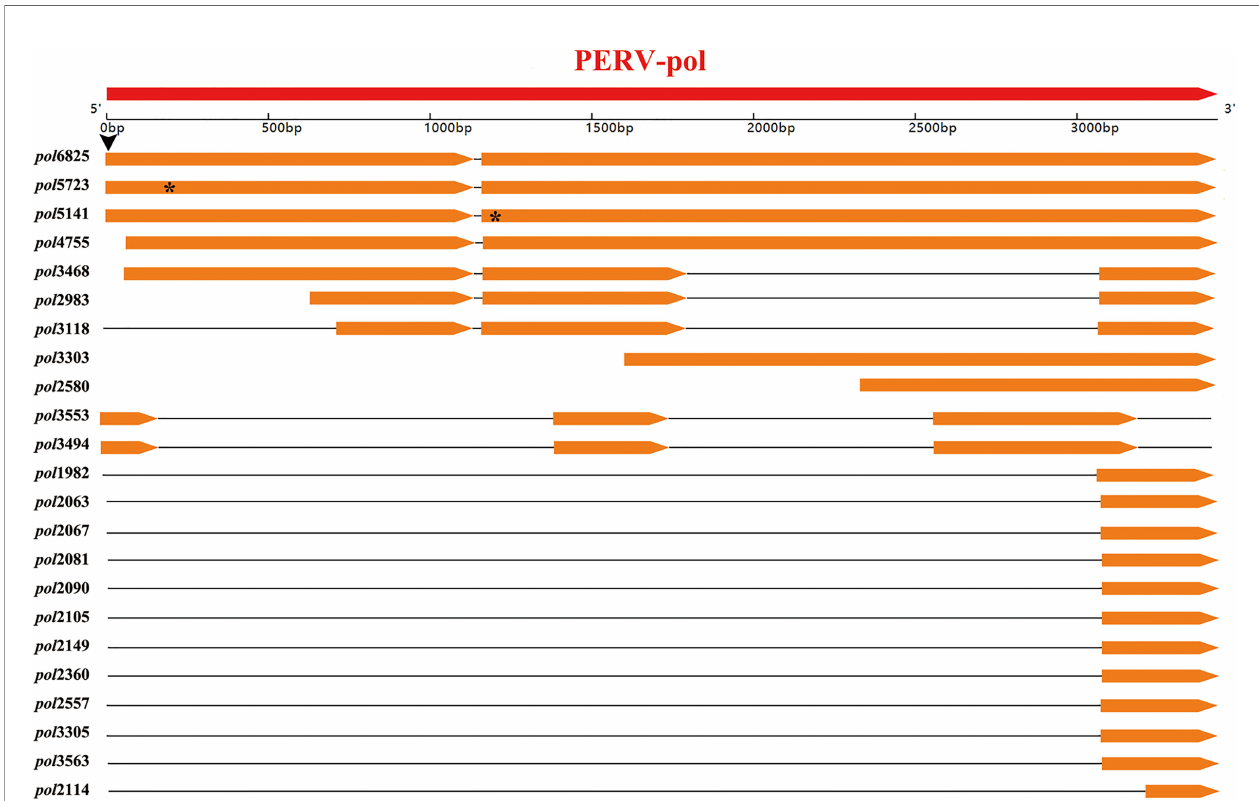
FIGURE 3 | Location of the detected 23 transcripts of WZSP425 on the PERV-WZSP pol gene. Arrow-rectangles in red indicated the ORF of PERV-WZSP pol gene, arrow-rectangles in orange indicated the detected 23 transcripts of WZSP452. Horizontal black lines represented deletions or introns of the gene. The black arrowhead indicated the position of a single base mutation (A>G), which results in the loss of start codon ATG of pol 6825. The “ * ” symbol marked the positions of the premature stop codons in the pol gene from the pol 5723 and pol